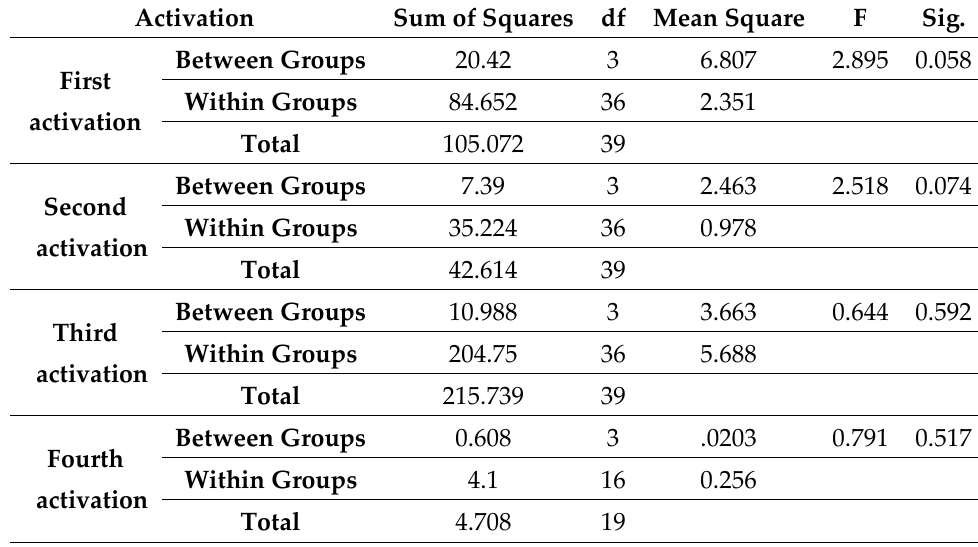
Table 5 ANOVA test for comparisons of rate of teeth movement between drug groups after different ac- tivation